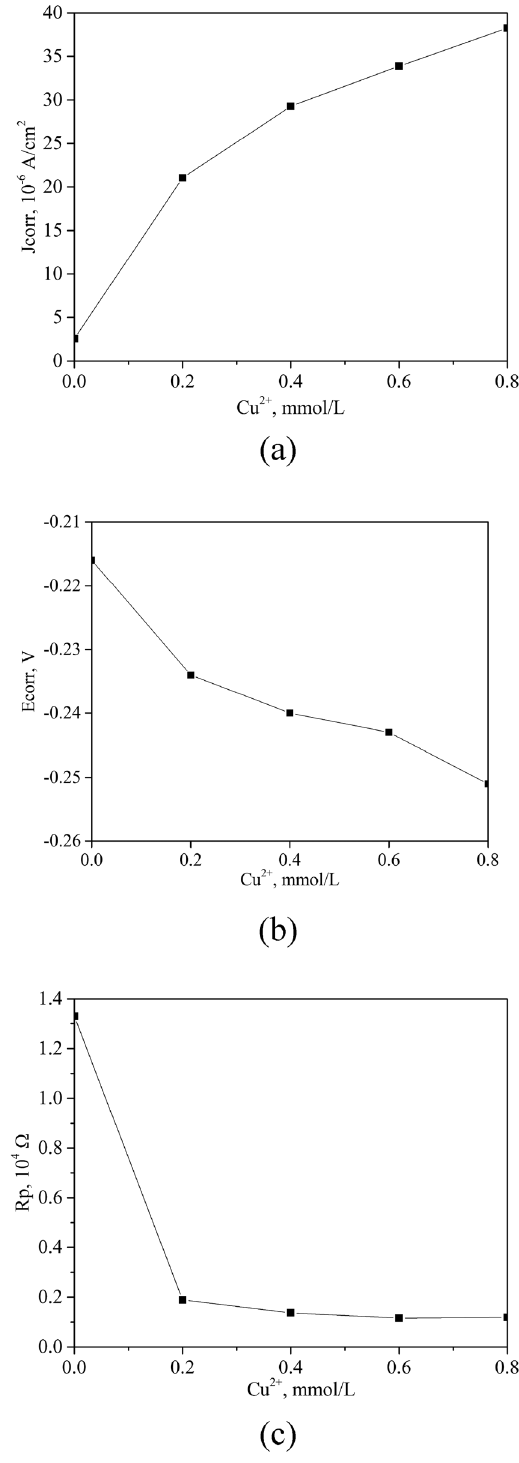
Figure 6: Electrochemical parameters of gold dissolution with di ff erent copper concentrations: ( a ) corrosion current density of gold dissolution; ( b ) corrosion potential of gold dissolution; and ( c ) polarization resistance of gold dissolution.